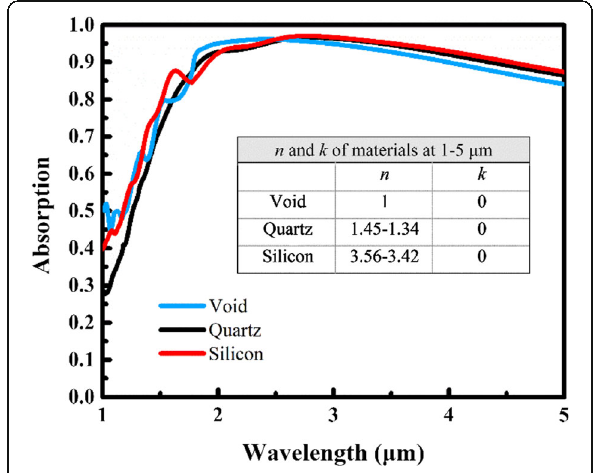
Fig. 9 Absorption of array A with different substrates. The